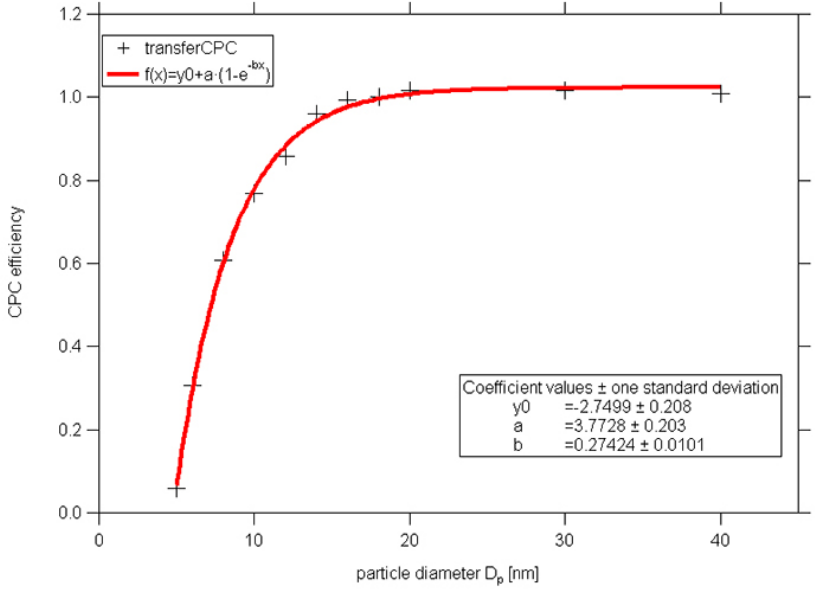
Fig. 2. Detection efficiency curve of the transfer CPC recorded on 24 October